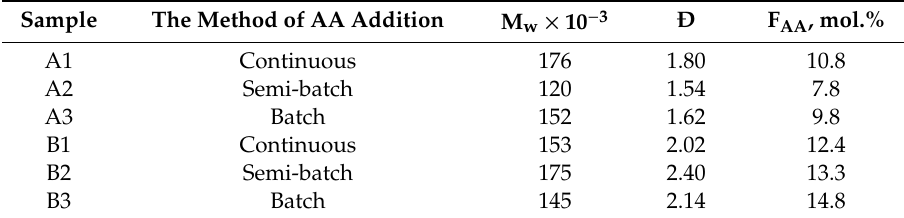
Table 1. Characteristics of the synthesized